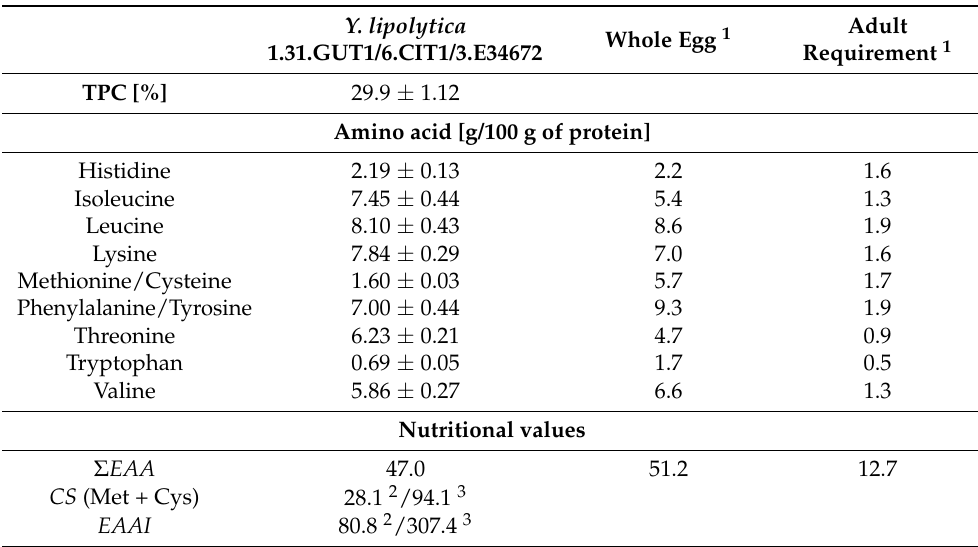
Table 3. Comparison of protein content and essential amino acid profile of Y. lipolytica 1.31.GUT1/ 6.CIT1/3.E34672 after cultivation on mixed (glycerol–oil)